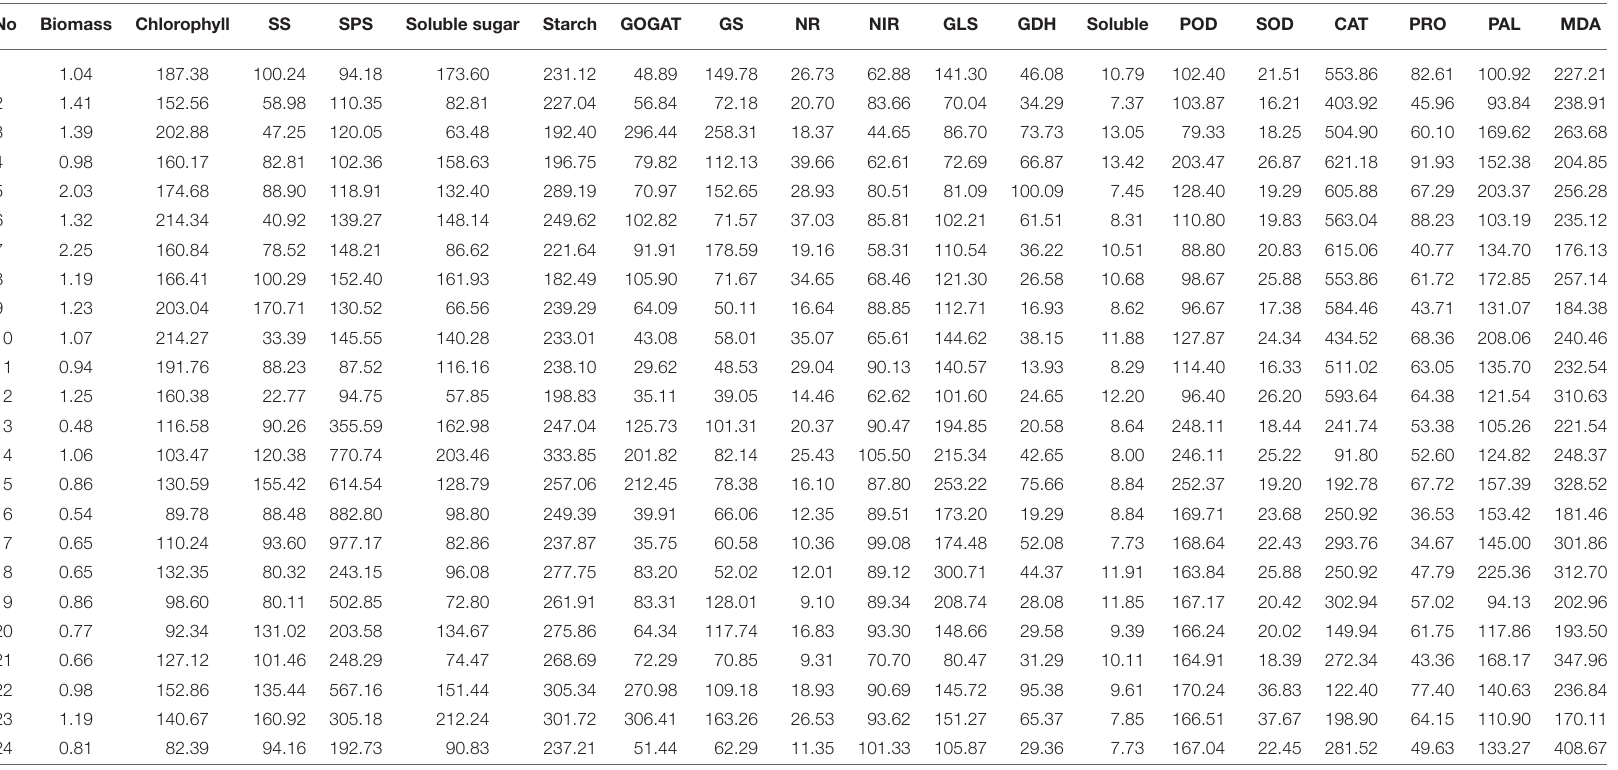
TABLE 1 | Biomass and physiological/biochemical indicators of S. miltiorrhiza